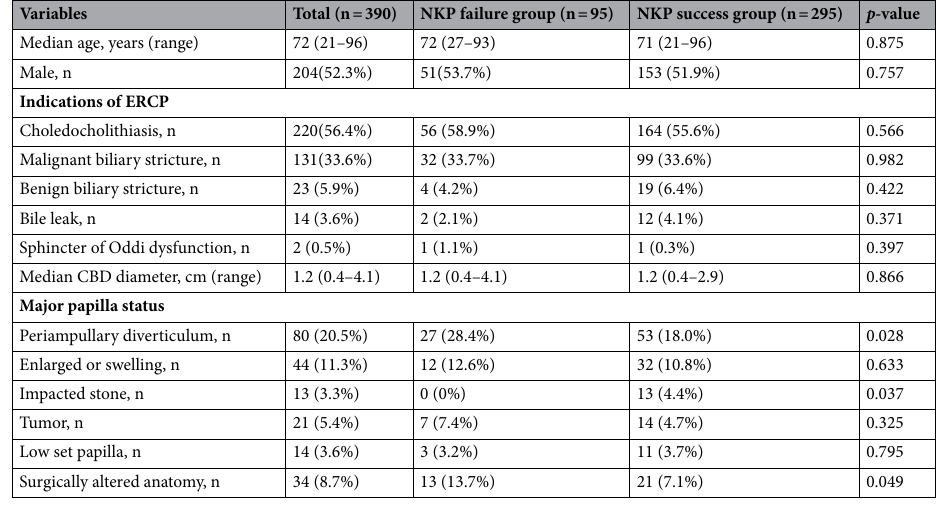
Table 1. Baseline characteristics of the patients. CBD common bile duct, NKP needle-knife pre-cut papillotomy, ERCP endoscopic retrograde cholangiopancreatography procedure.